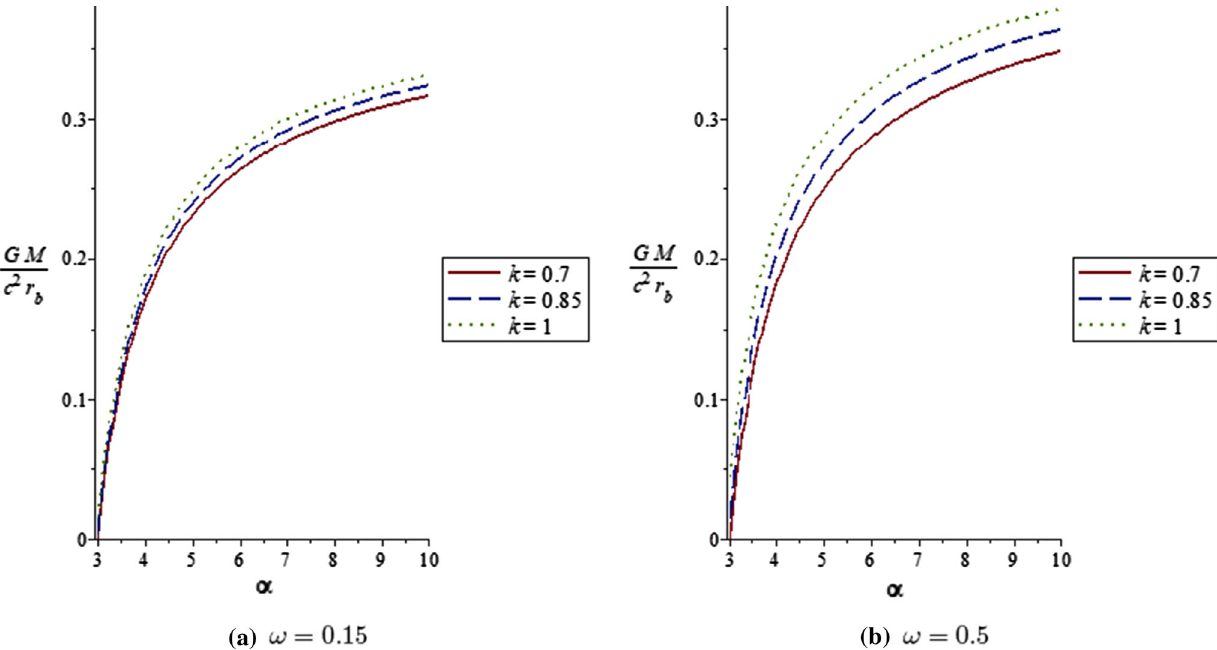
Fig. 3 The dimensionless quantity related with the total mass as a function of α for ω = 0 . 15 ( a ) and ω = 0 . 5 ( b )